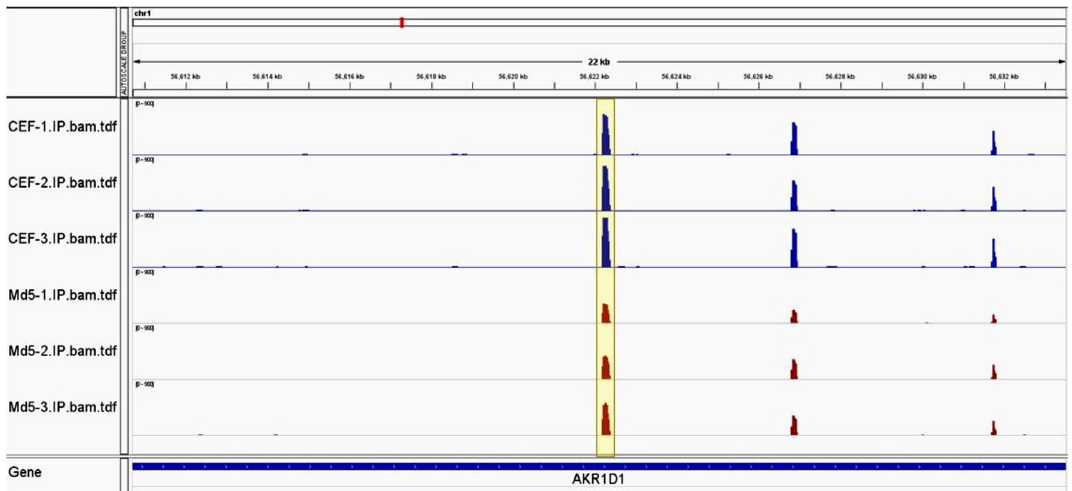
Figure 5. Chromosome visualization of m 6 A sites in lncRNAs. Red represents the infected group while blue represents the control group. Md5-1, Md5-2, Md5-3 represent the Md5-infected CEF group with three independent replicates. Differentially methylated m 6 A peaks visualized in Md5-infected group and control group. The highlighted area represents one of the differential methylation